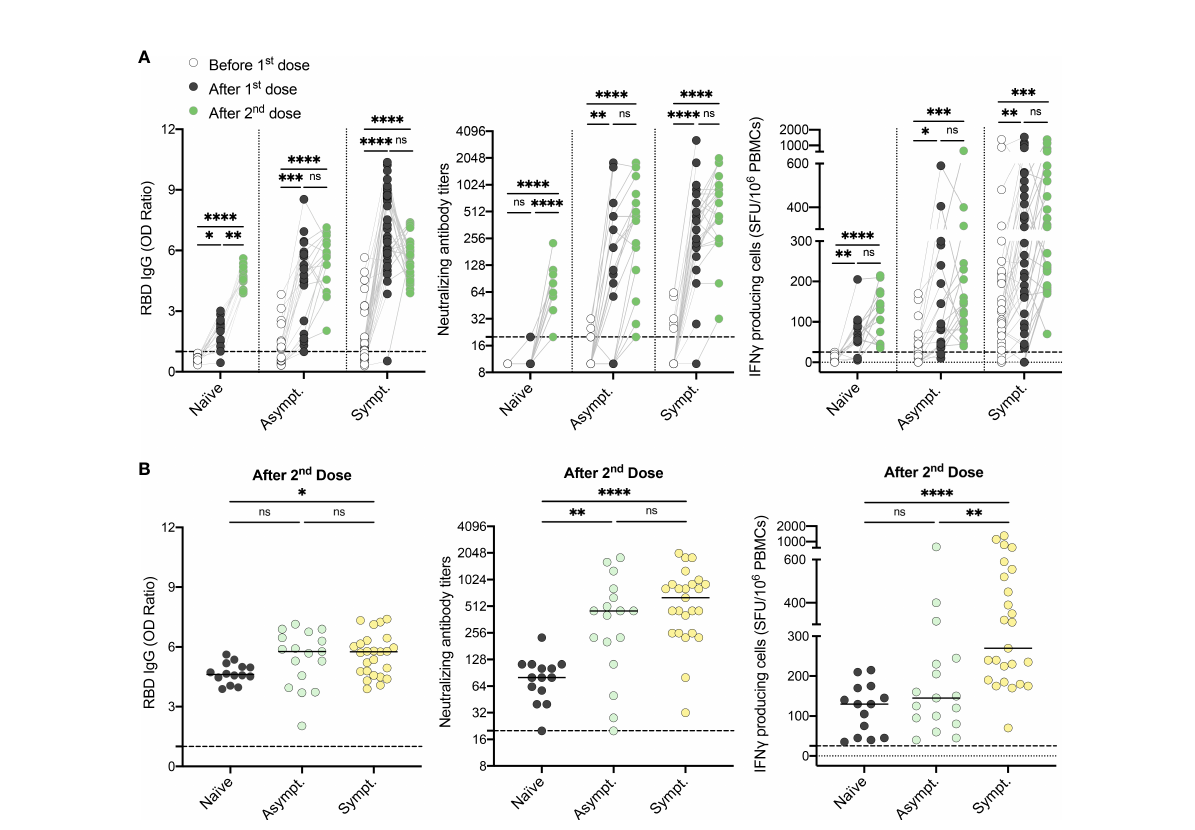
FIGURE 5 Two doses of vaccine are required for individuals who recovered from an asymptomatic SARS-CoV-2 infection to generate a global and coordinated adaptive immune response. (A) SARS-CoV-2 Spike RBD – speci fi c binding IgG levels assessed by ELISA (left panel), SARS-CoV-2 neutralizing antibody titers (middle panel), IFN- g secreting cells per million in response to SARS-CoV-2 Spike glycoprotein peptides (right panel) assessed by ELISpot for naïve (n=14), asymptomatic (n=17) and symptomatic recovered HCWs (n=25) before (white circles), after one dose (black circles) and after two doses of vaccine (green circles). (B) SARS-CoV-2 Spike RBD – speci fi c binding IgG levels assessed by ELISA (left panel), SARS-CoV-2 neutralizing antibody titers (middle panel), and IFN- g secreting cells per million in response to SARS-CoV-2 Spike glycoprotein peptides assessed by ELISpot (right panel) for naïve (black circles), asymptomatic (n=17) and symptomatic (n=25) recovered HCWs after two doses of vaccine. Dashed black lines indicate the positive threshold value. Horizontal bars indicate the median of each group. Kruskal- Wallis tests assessed statistical signi fi cance. Not signi fi cant (ns) P >.05; *P <.05; **P <.01; ***P <.001; ****P